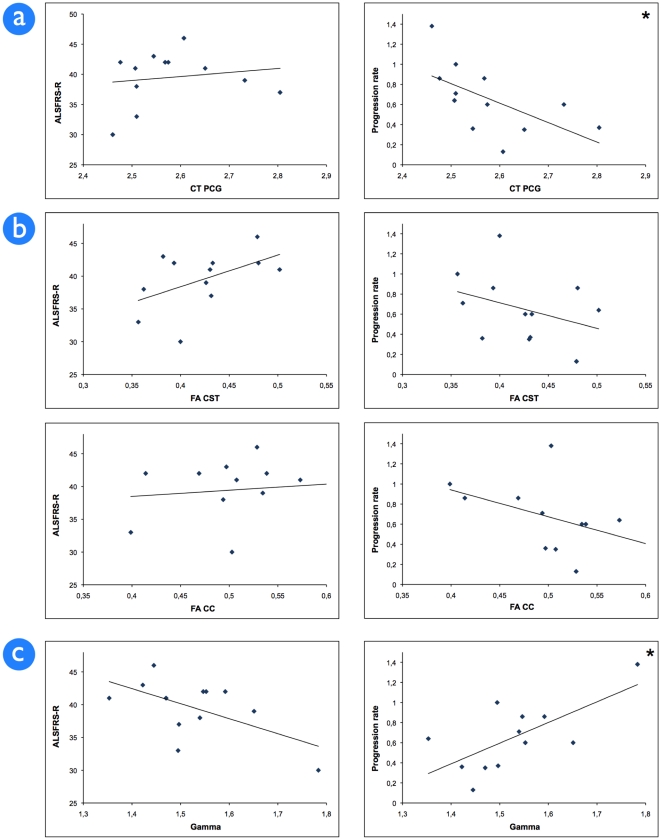
Correlation of imaging parameters with clinical measures.Correlation of ALSFRS-R score and progression rate with; a) cortical thickness in the precentral gyrus (CT PCG) of the clinically most affected side. Cortical thickness is corrected for average whole brain cortical thickness and age; b) FA in the -rostral part of the- corticospinal tract (CST) and FA in the corpus callosum (CC); c) Gamma - or local connectedness - corrected for the number of functional connections and age (threshold 0.30). * p<0.05, ALSFRS-R  =  ALS Functional Rating Scale Revisited. FA  =  fractional anisotropy. CST  =  corticospinal tract. CC  =  corpus callosum.